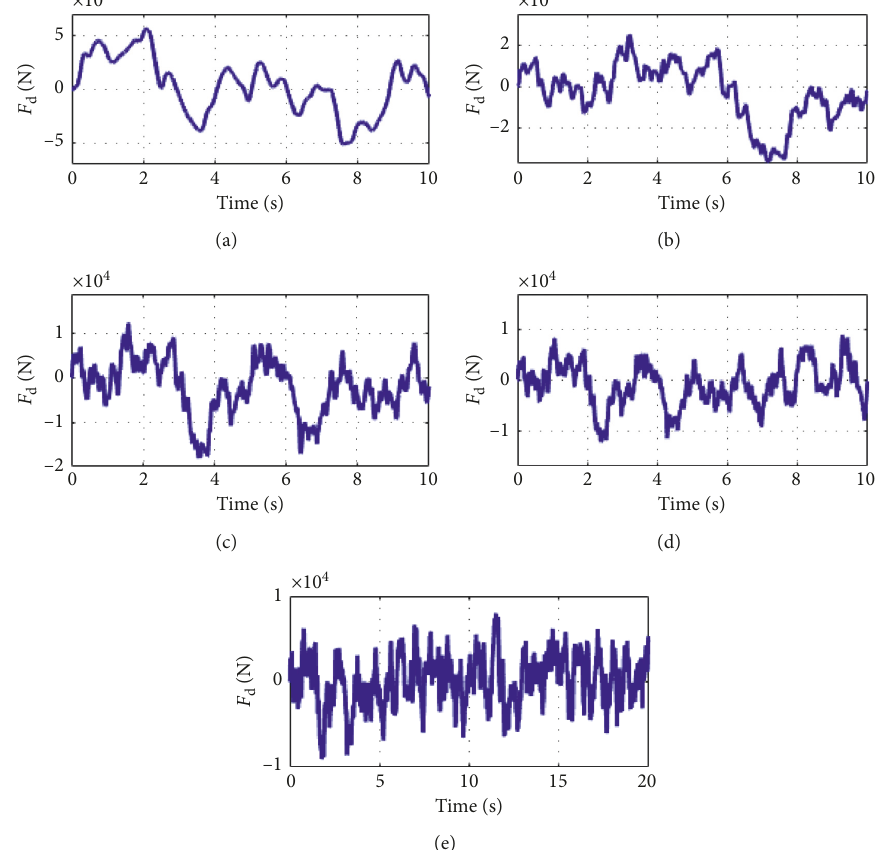
Figure 19: The F d estimation versus the velocity of the car. (a) 5km/h. (b) 20 km/h. (c) 40km/h. (d) 60km/h. (e)